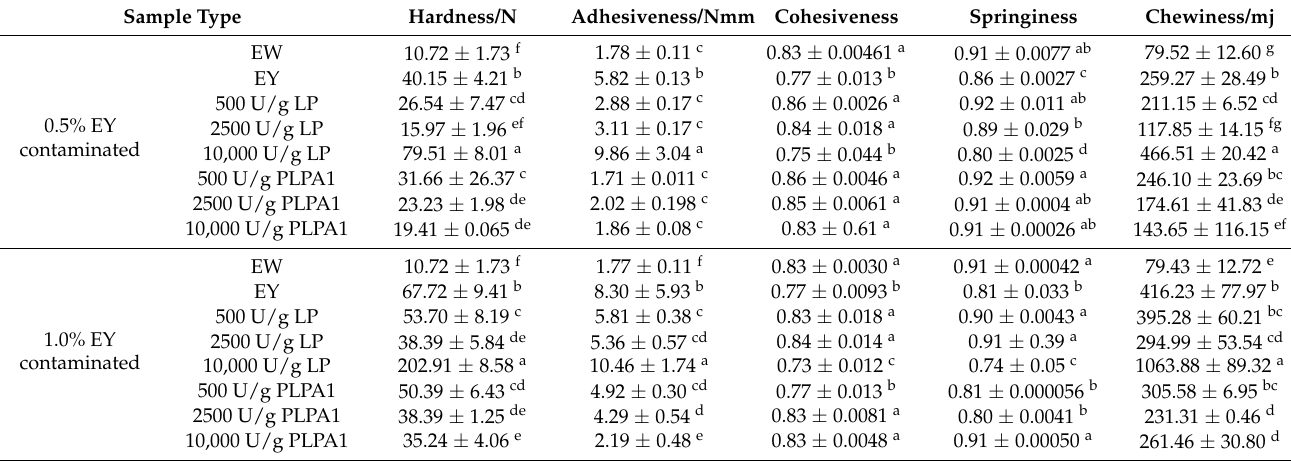
Table 3. Texture profile analyses of angel food cakes obtained from yolk-contaminated EW through different